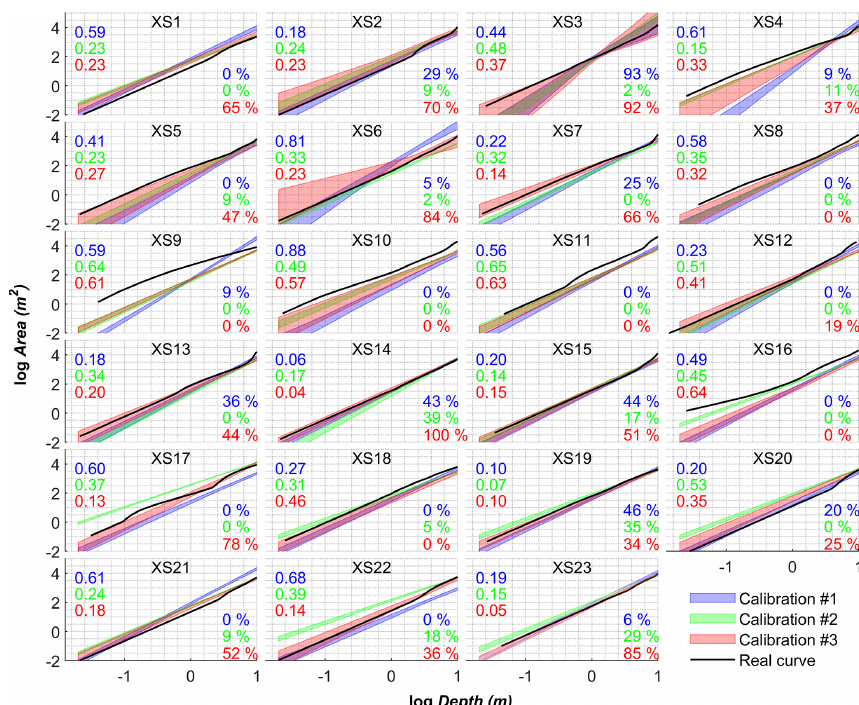
Figure 4. Calibrated area–depth curves at 23 cross-sections (number is given in each plot). Three scenarios are shown, i.e., calibration with water surface elevation data only (calibration #1), river width only (calibration #2), and both water surface elevation and width (calibra- tion #3), respectively. Please refer to Table 1 for more information. The color band represents the mean ± standard deviation based on an ensemble of 10 calibrations. RMSE and coverage (percentage of real data falling into the calibrated interval) of calibrated curves against real data are reported on the left and right sides of each plot, respectively. Font color is consistent with the curve color. Table 1. Details of the calibration scenarios with different data sets. Scenario Description No. of No. of WSE width Calibration #1 Calibration with WSE observations only 261 0 Calibration #2a Calibration with one width per 5km 0